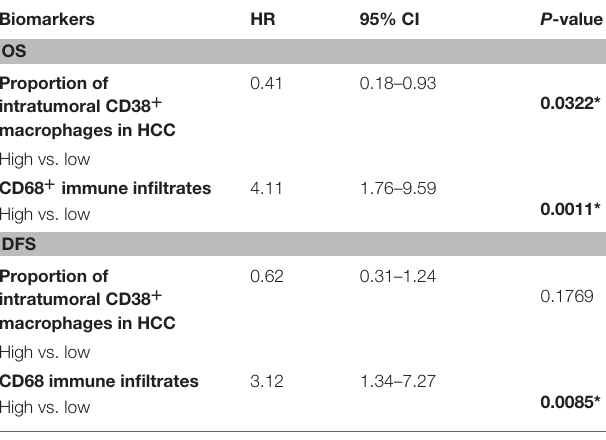
TABLE 1 | Multivariate analysis of the effect of intratumoral macrophage density on OS and DFS, adjusted for tumor size, grade, age, and lymph node status.